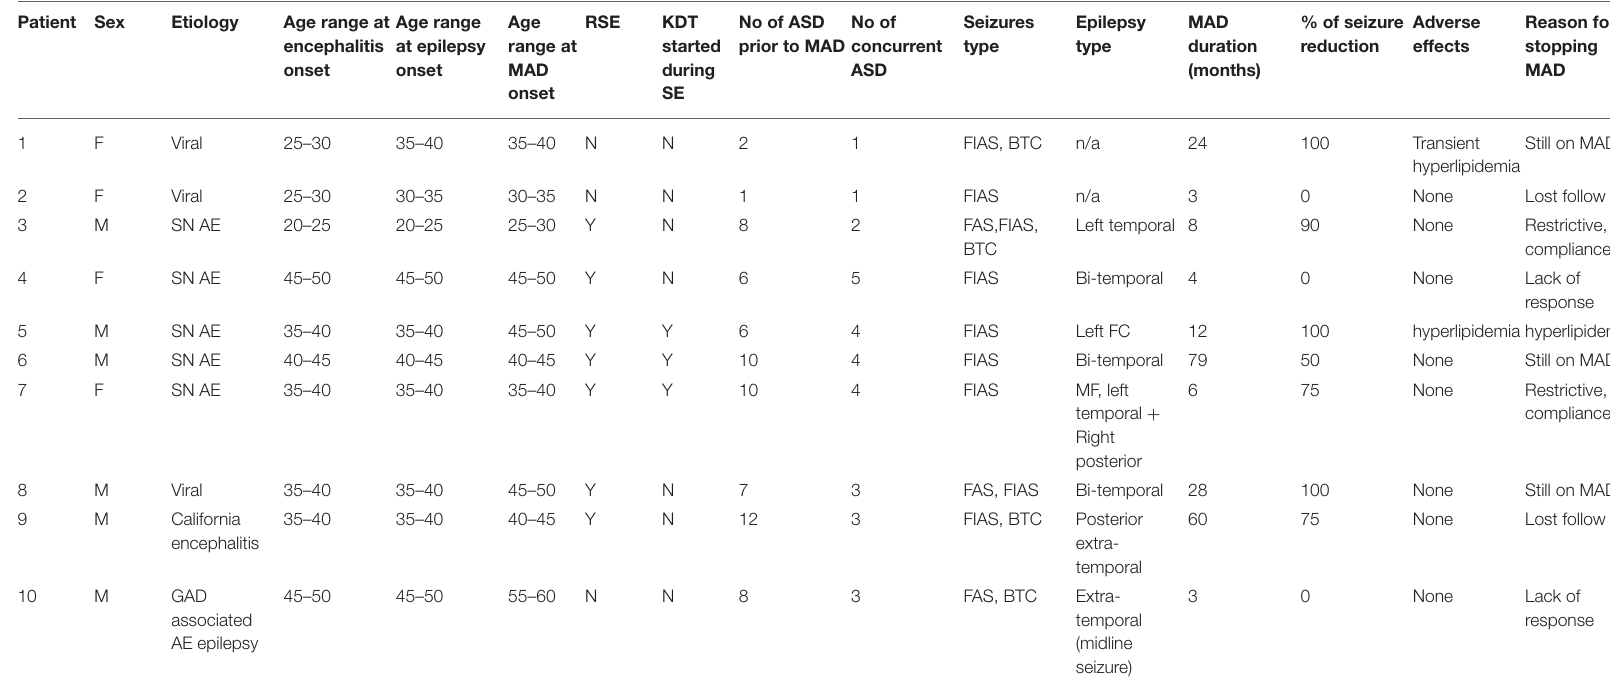
TABLE 2 | Full details of all 10 patients with post-encephalitic and auto-immune associated epilepsy treated with the modified Atkins